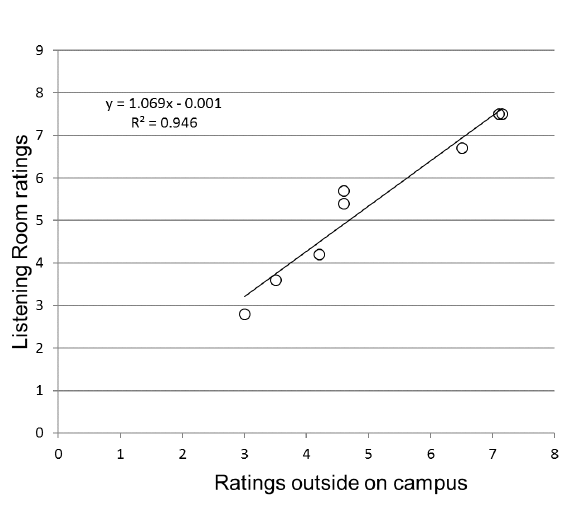
Figure 5: Comparison of ratings made outside and in the laboratory implies that 95% of the variance could be explained by the direct relationship.